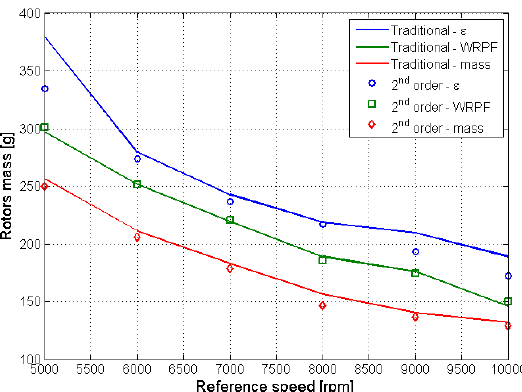
Figure 18. Second-order optimization: mass.